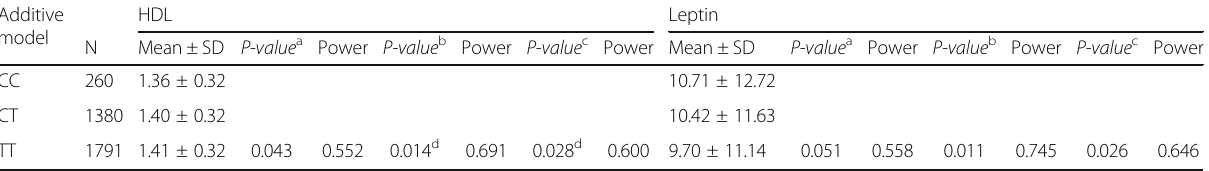
Table 1 Associations of rs11191548 with HDL and leptin Additive model